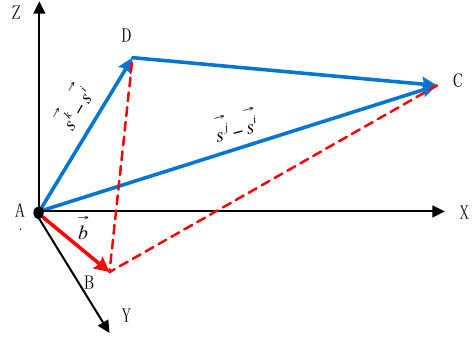
Figure 4. The spatial relation of two DD equations.